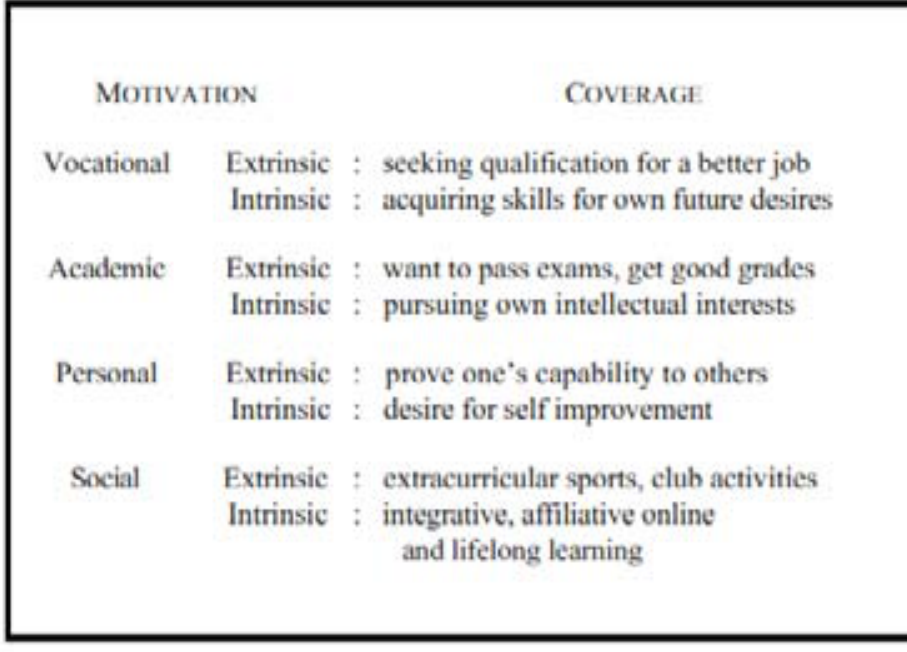
Figure 6 . The motivation to learn (Kawachi,